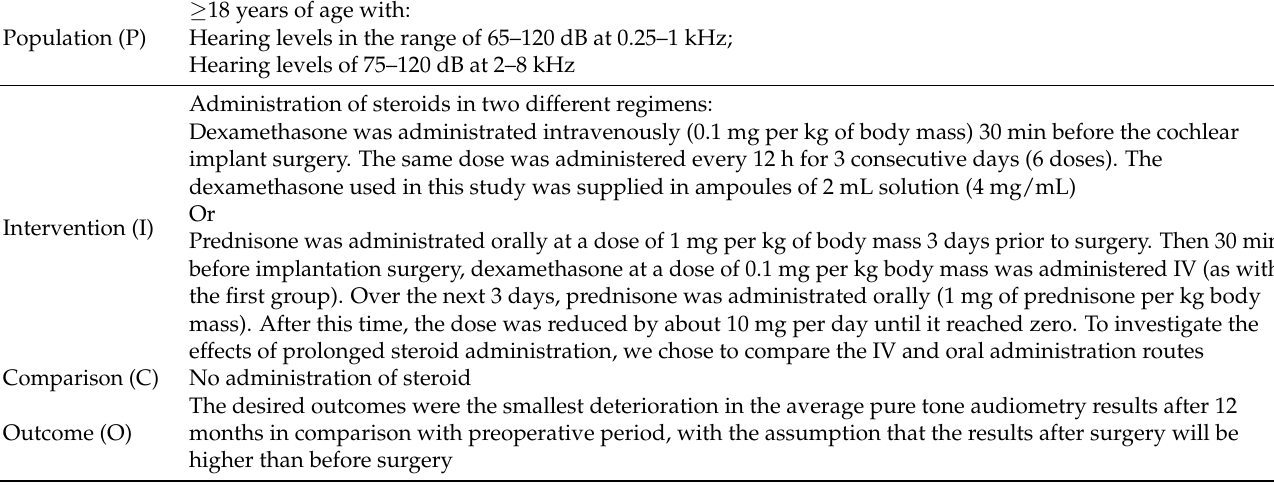
Table 2. Shows the PICO classification (P—population, I—intervention, C—comparison, O—outcome) in which each component is precisely